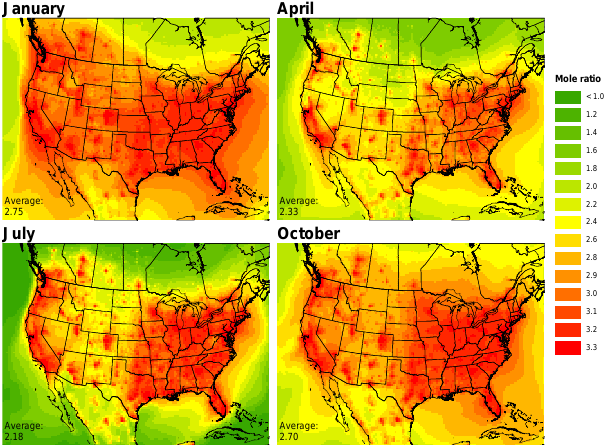
Figure 7. Modeled monthly averaged D 6 / D 5 mole ratios by sea- son. Larger cVMS species react faster with OH. More reactive species are in the numerator; therefore, ratios decrease with air mass